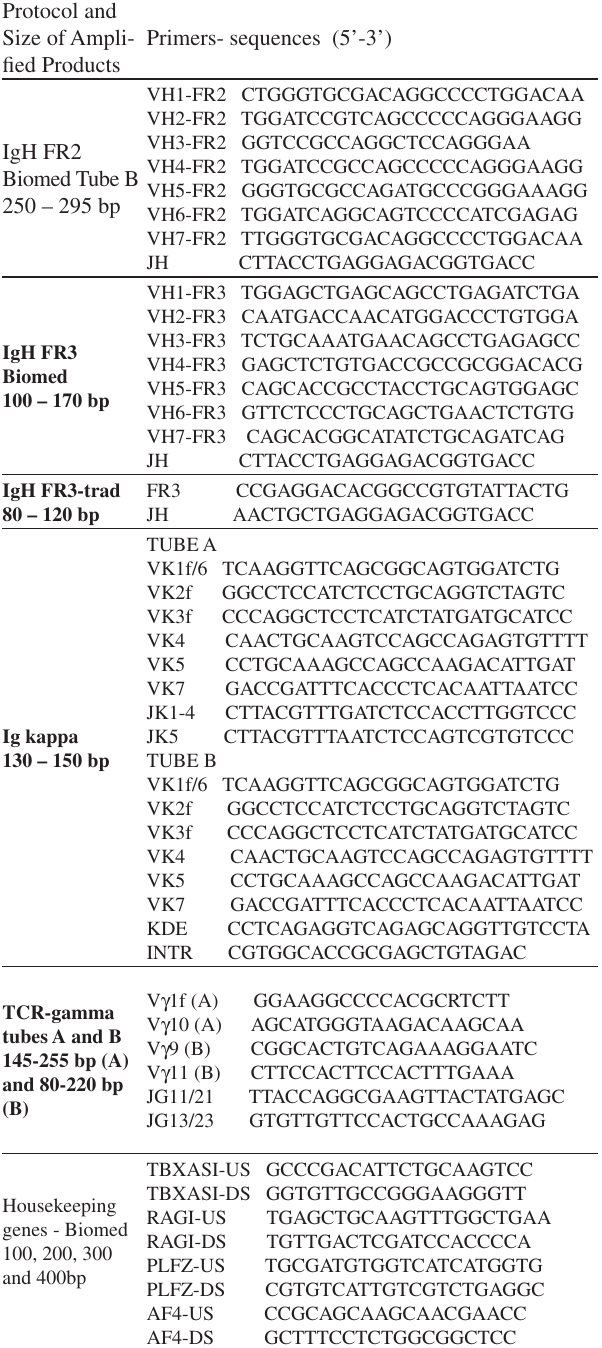
Table 2 - Sequences of primers used in the different DNA